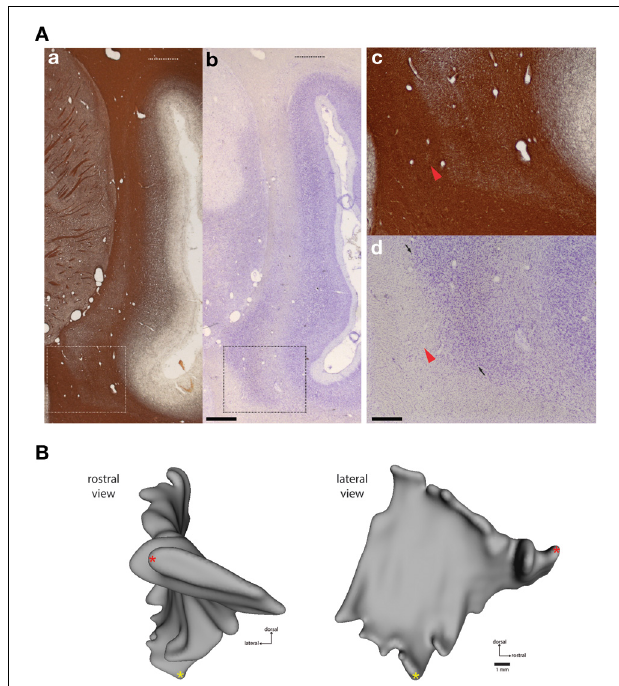
FIGURE 1 | Histological boundaries of Cebus claustrum. (A) Myelin (a,c) and nissl (b,d) stained frontal sections showing the dorsal and ventral extent of the claustrum at approximately A-P + 13.0 in the atlas of Eidelberg and Saldias (1960). Dashed lines in the low magnification images (A) show the maximum dorsal extent of the claustrum, which is difficult to appreciate in most histological preparations. The rectangular outlines in (a,b) indicate areas shown at high magnification in (c,d) . Panels (c,d) show the difficulty of accurate estimation of the ventromedial boundary of the claustrum in standard histological preparations. Red arrowheads show a small cluster of cells separated from the putative claustrum boundary by a portion of the external capsule white matter. Small arrows in (d) show the approximate boundary between the dorsal endopiriform nucleus and the insular claustrum as estimated from the histological characteristics of the marmoset (Paxinos et al., 2012). Detailed cytoarchitectonic information is not currently available for Cebus , so this parcellation should be considered provisional, pending identification of reliable markers of internal and external claustrum boundaries in this species. Scale bars = 1mm in (b) ; 0.2mm in (d) . (B) shows frontal (left) and lateral (right) views of case FR01, modeled as described in Materials and Methods. The lateral view was used as the template for heat mapping of tracer distribution in subsequent figures. Red and yellow asterisks provide common points of reference for the rotated